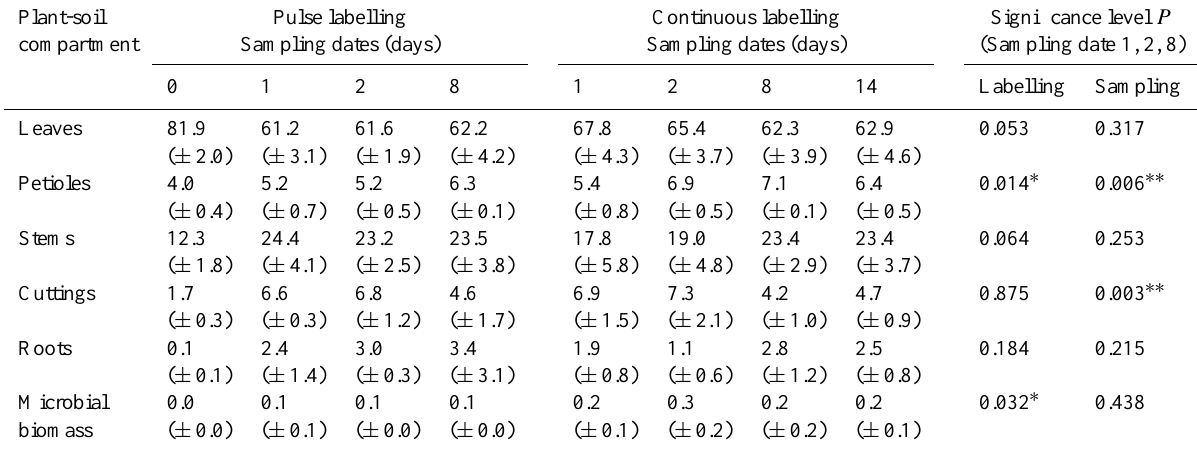
Table 3. Estimation of C partitioning between plant and soil compartments indicated by the relative 13 C distribution (in %) and for the different sampling dates after pulse and during continuous labelling ( ± one standard deviation is indicated in brackets). The effects of labelling technique (“labelling”) and sampling date (“sampling”) were tested for the sampling dates in common (1, 2 and 8days) by two-way analysis of variance